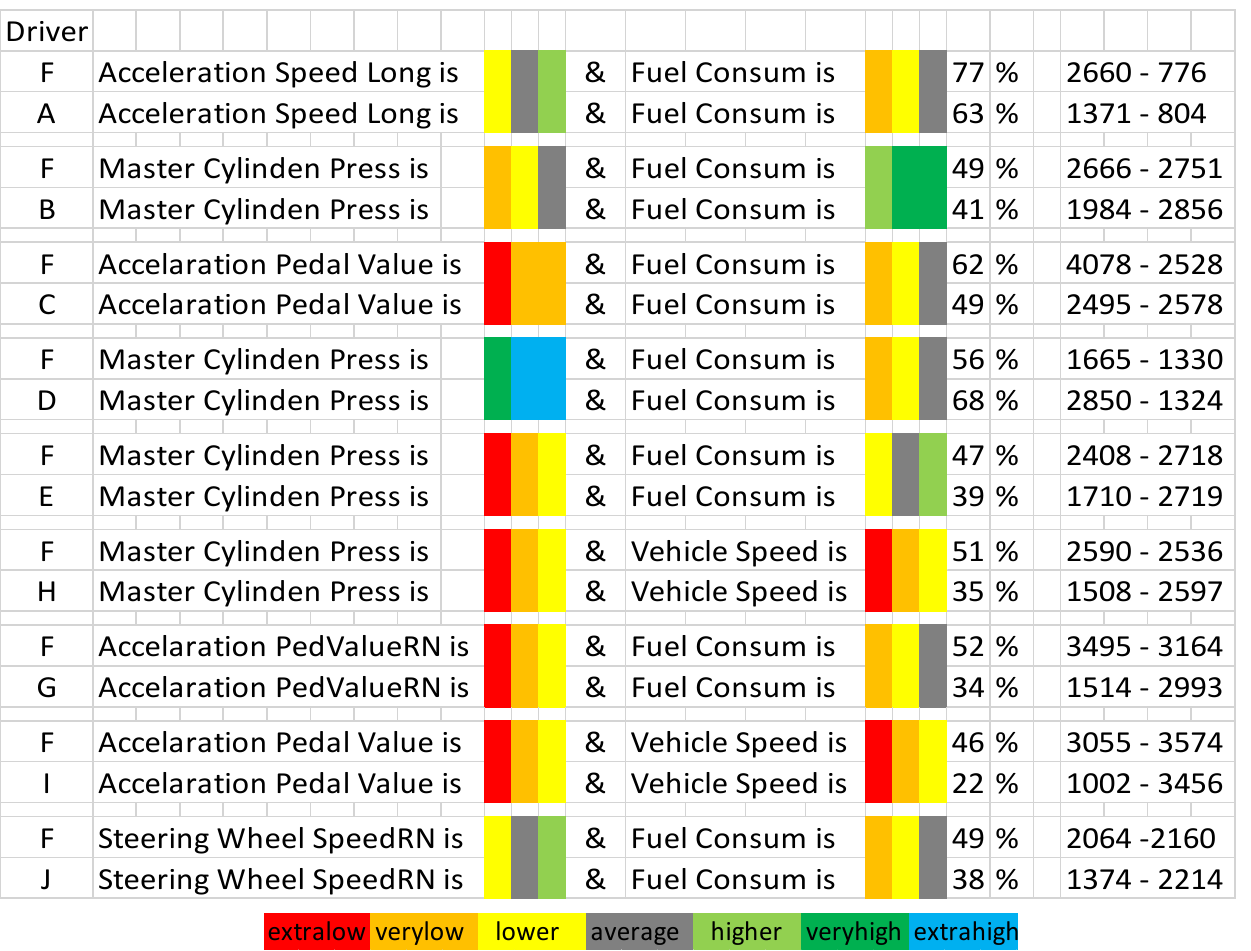
Figure 6. Hypotheses that distinguish driver F in pairs from other drivers (by